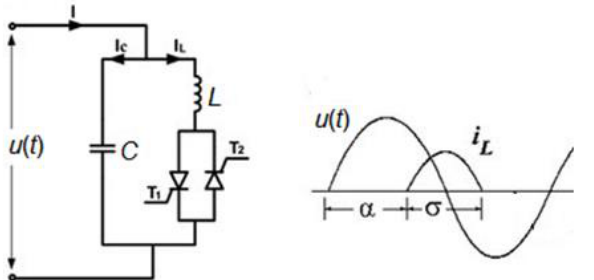
Figure 10. Idea of SVC operating.